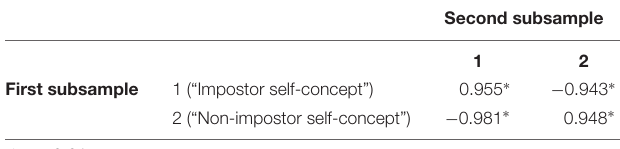
TABLE 2 | Correlation matrix between the two-cluster solutions.